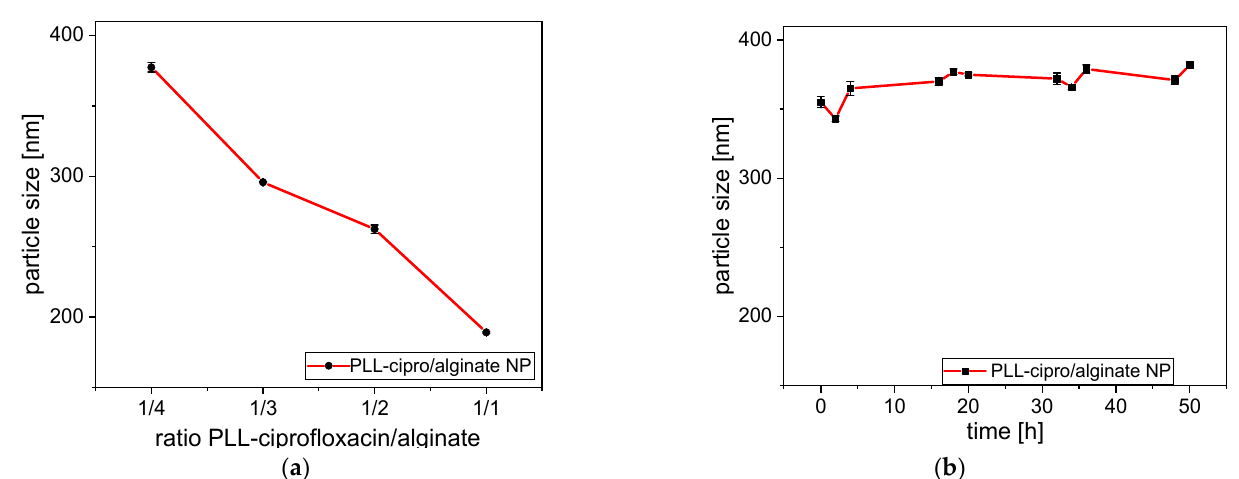
Figure 2. ( a ) Dependence of the size of nanogels prepared with different PLL-ciprofloxacin/alginate ratios at RT in deionized water; ( b ) size of the nanoparticles (PLL-ciprofloxacin/alginate 1/3) as a function of incubation time in phosphate buffer saline (pH 7.4) at 37 °C. The particle size for the 1/3 mixture here was somewhat higher because of the buffer and the higher temperature.